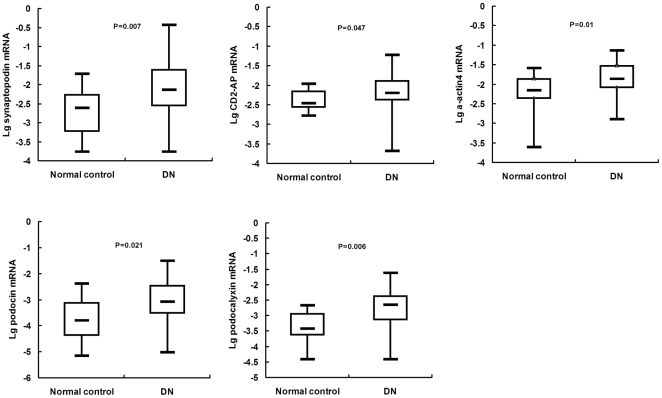
Comparison of podocyte-associated mRNA expressions in urinary between DN patients and health controls.Box plots show the minimum value, 25th, 50th (median), 75th, and the maximum values for lg-transformed ratios of mRNA copies compared with β-actin mRNA copies for synaptopodin, CD2-AP, α-actin4, podocin, and podocalyxin. Data were compared using the Mann-Whitney U test. DN  =  Diabetic nephropathy.